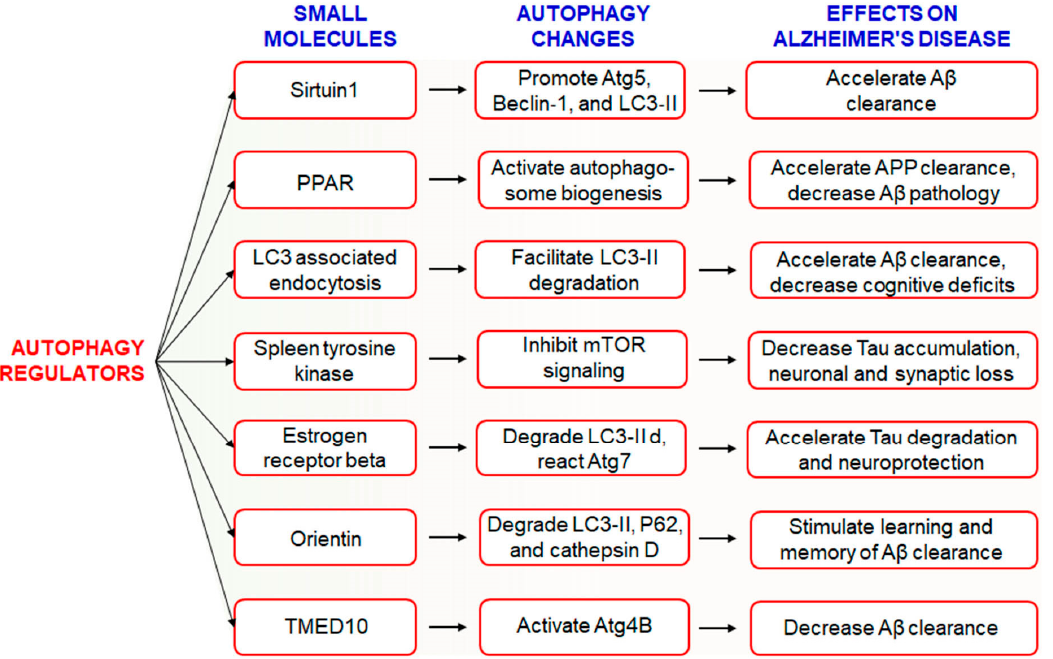
Figure 6. Implication of several small molecules that modulate autophagy and their mode of action in AD treatment. It has been mentioned that a single drug may target multiple factors that might be involved in diverse pathological conditions thereby augmenting treatment efficacy. Additionally, it has been limited negative features of a conventional single-target drug and combination drugs as well. All the small molecules are used to treat AD via modulation several autophagic